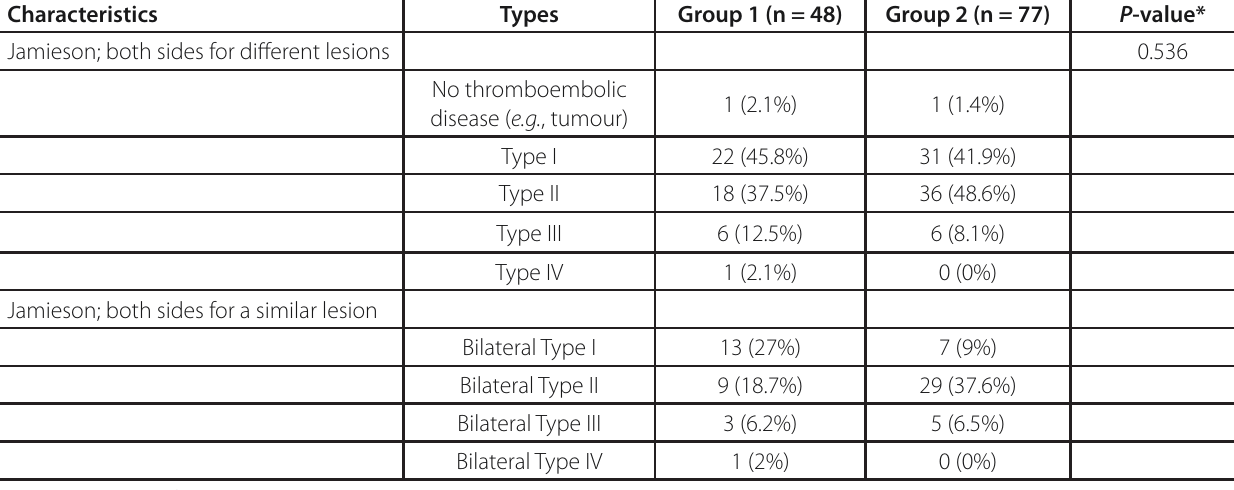
Table 2. Jamieson Surgical Thromboembolic